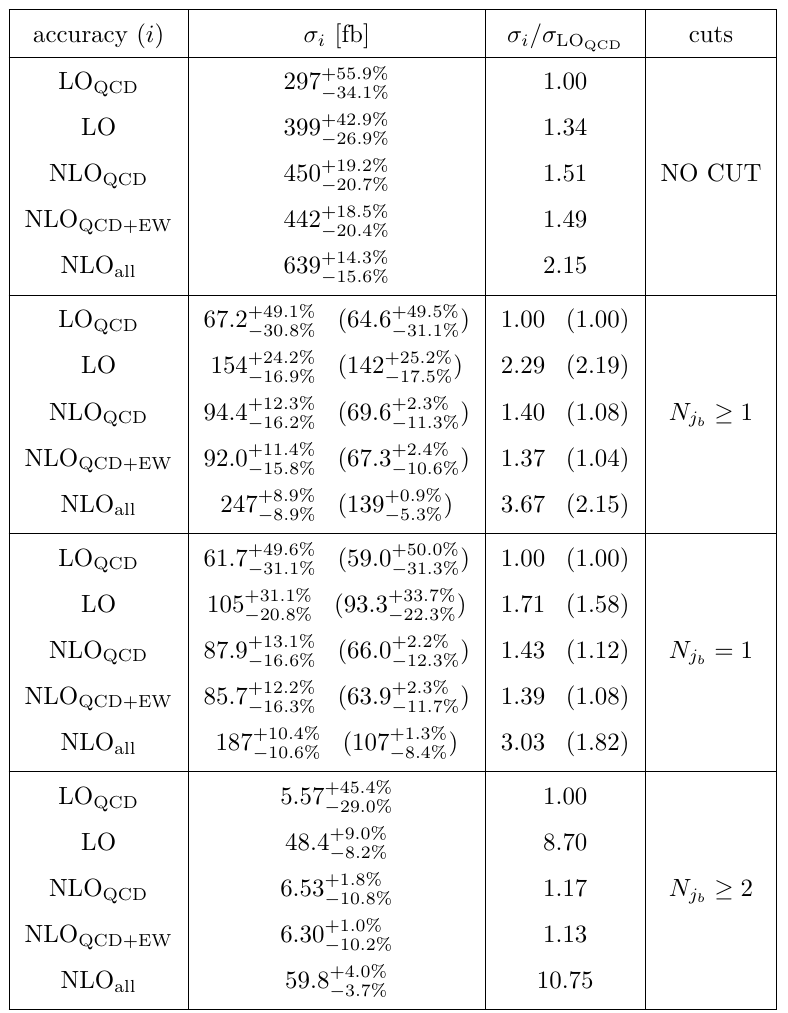
Table 2 . Cross sections, with relative scale uncertainties, at different perturbative accuracies and with different phase-space cuts. Numbers in parentheses are obtained by vetoing light jets. Details are explained in the